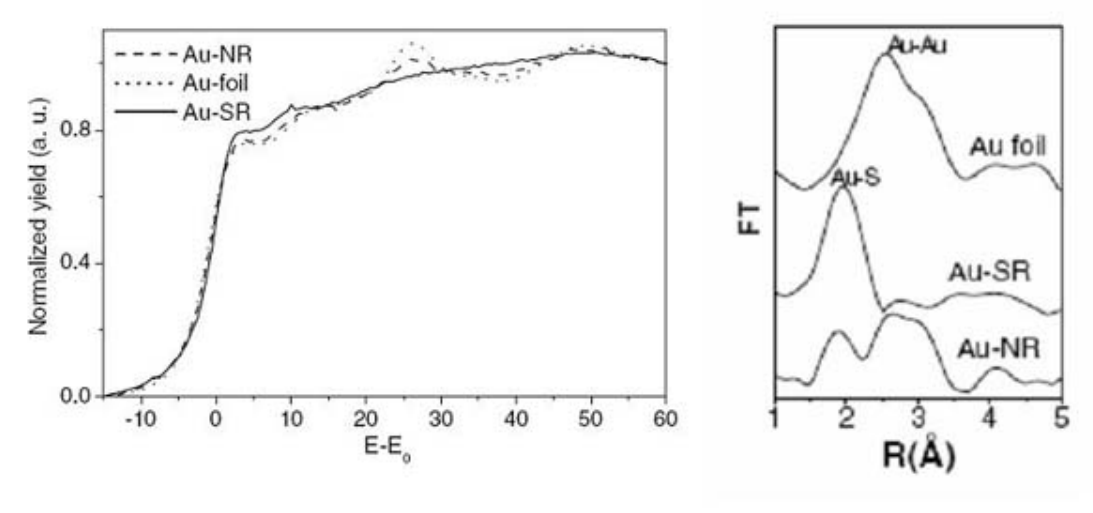
FIGURE 12. (Left) XANES spectra of Au NP capped with two different molecules. The spectra of foil Au is also presented for comparison. (Right) EXAFS spectra corresponding to the same samples. From Ref.